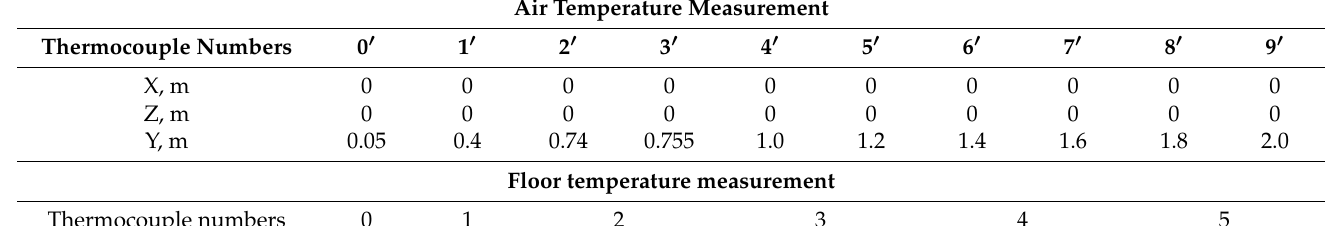
Table 2. Coordinates of the thermocouples’ location (Figures 1 and 2) in the measurement area.